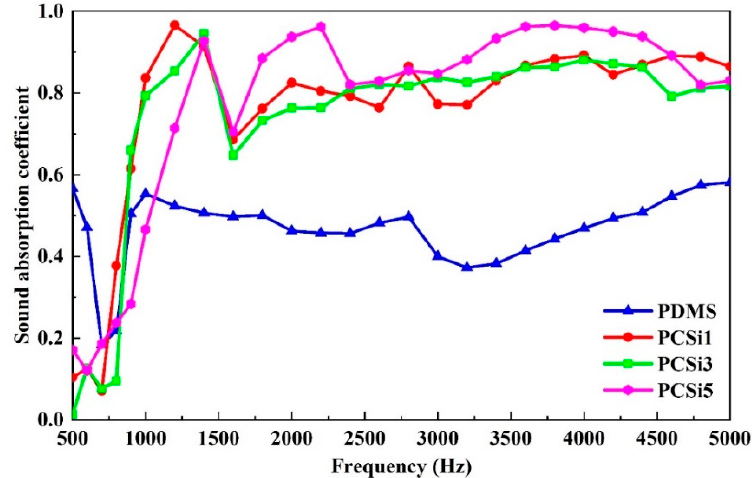
Figure 10. Underwater acoustic absorption performance of different